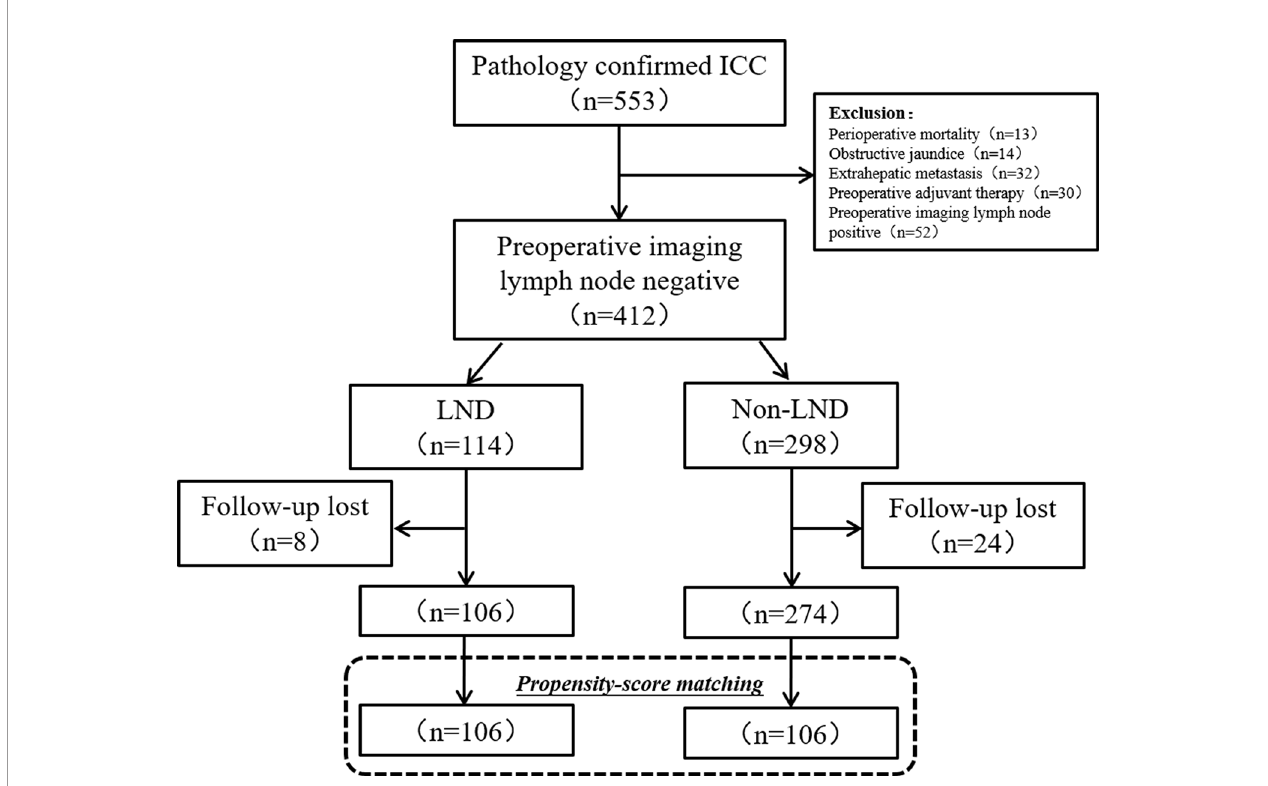
FIGURE 1 | Flow chart of patients ’ enrollment. ICC, intrahepatic carcinoma; LND, lymph node